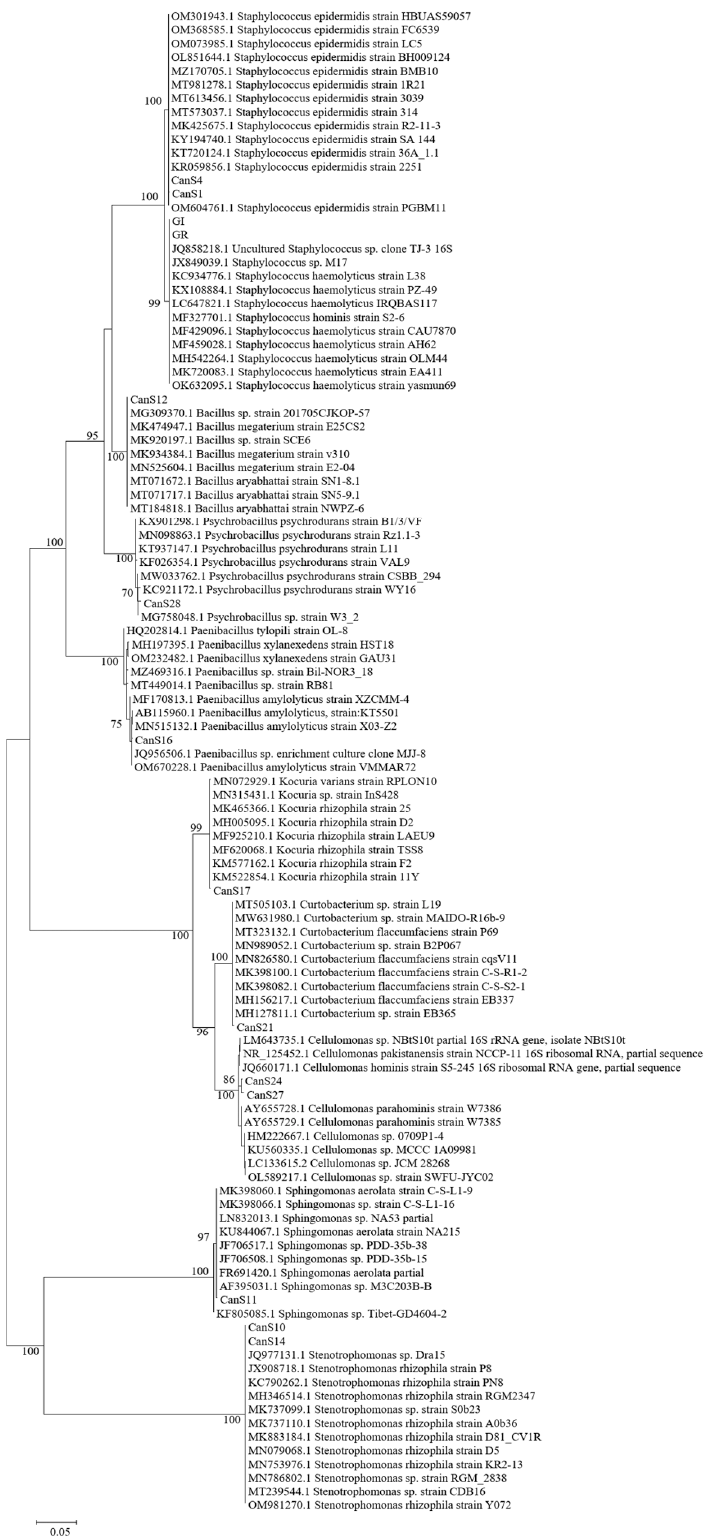
Figure 2. Phylogenetic tree reconstruction based on the 16S rRNA gene, obtained with maximum- likelihood method on a total of 110 sequences, 14 of them belonging to our strains and 96 high-quality sequences selected among those most similar to our isolated